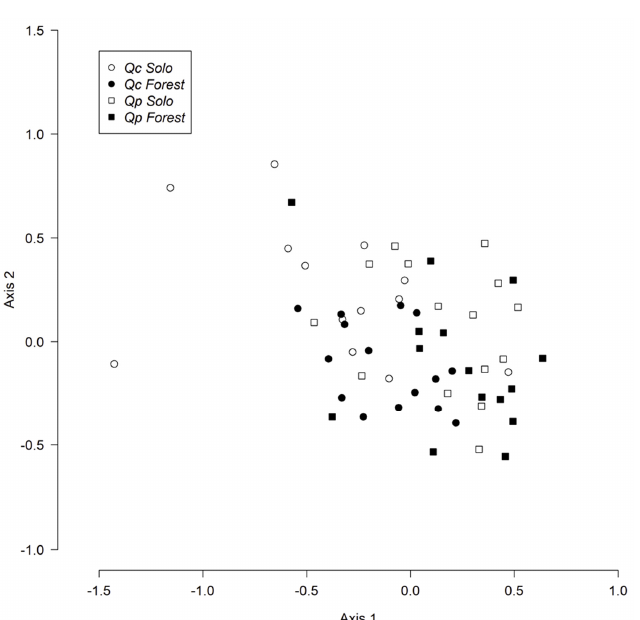
Figure 7. Non-metric multidimensional scaling of caterpillar assemblages on young LF Quercus cerris and EF Q. pubescens . (Qc— Q. cerris , Qp— Q. pubescens , Solo—lone trees growing in open forest glades or edges out of the crowns of mature Q. pubescens , Forest–trees in the forest interior un- der the crowns of mature Q. pubescens ) Agriopis leucophaearia (Figure 8). It was a predominant species also on young LF Q. cerris (dominance in the forest interior: 83%, lone trees: 77%) and EF Q. pubescens (within the forest: 70%, lone trees: 67%). In the forest interior, there was a non-significant differ- ence between caterpillar abundances on Q. cerris and Q. pubescens (z = 0.559, p > 0.100). On lone trees, their abundance on Q. cerris was significantly lower than that in the forest in- terior (z = − 3.390, p = 0.005) while on Q. pubescens it was relatively high, and the difference between abundances, in both microhabitats, was not signi fi cant (z = − 1.309, p > 0.100).